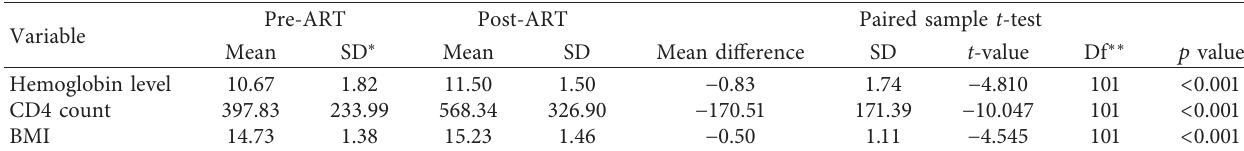
Table 5: Comparison of selected variables using paired sample t -test before the initiation of ART and one year after the initiation of ART regimen.